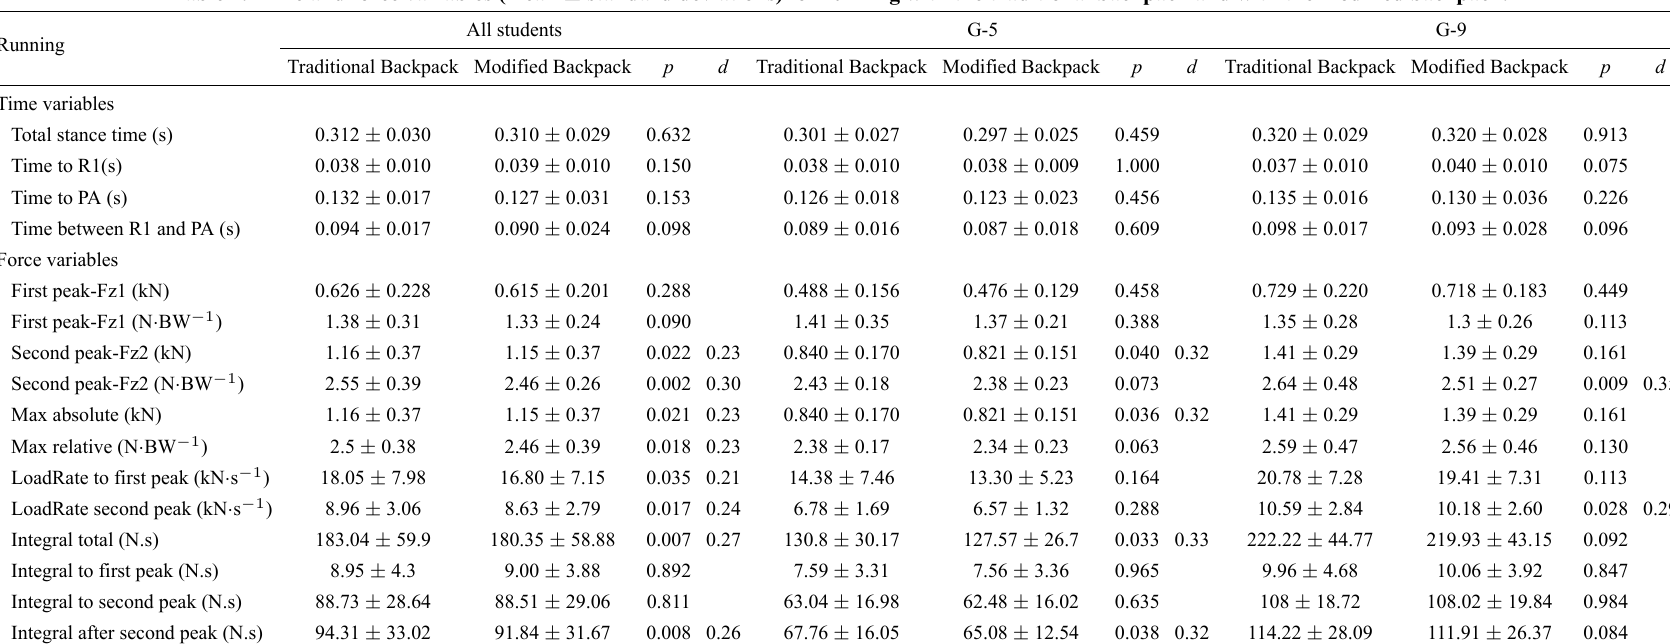
Table 2. Time and force variables (mean ± standard deviations) for running with the traditional backpack and with the modified